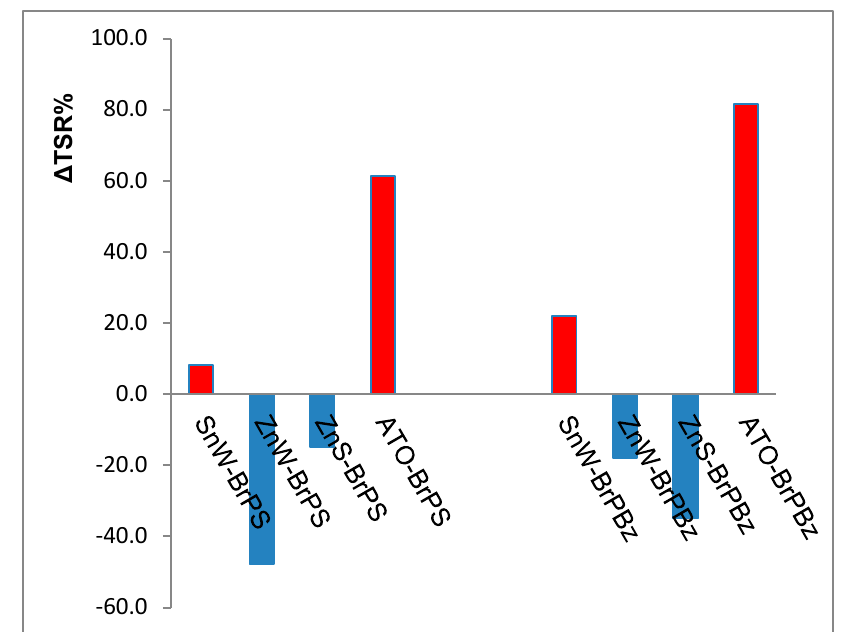
Figure 5. Percentage changes in smoke generation where the percentage change in total smoke release, Δ TSR% = (TSR (MC/BrFR) /TSR (BrFR) − 1) × 100 and TSR (MC/BrFR) and TSR (BrFR are the respective smoke release values for each synergist and tungstate (MC) in combination with each BrFR and each BrFR alone in PA66: Red columns indicate an increase and blue columns a decrease in smoke generation with respect to that from either brominated polystyrene, BrPS, or poly(pentabromobenzyl acrylate), BrPBz, present in PA66 alone. SnW and ZnW = tin (II) and zinc tungstates respectively; ATO = antimony (III) oxide and ZnS = zinc stannate